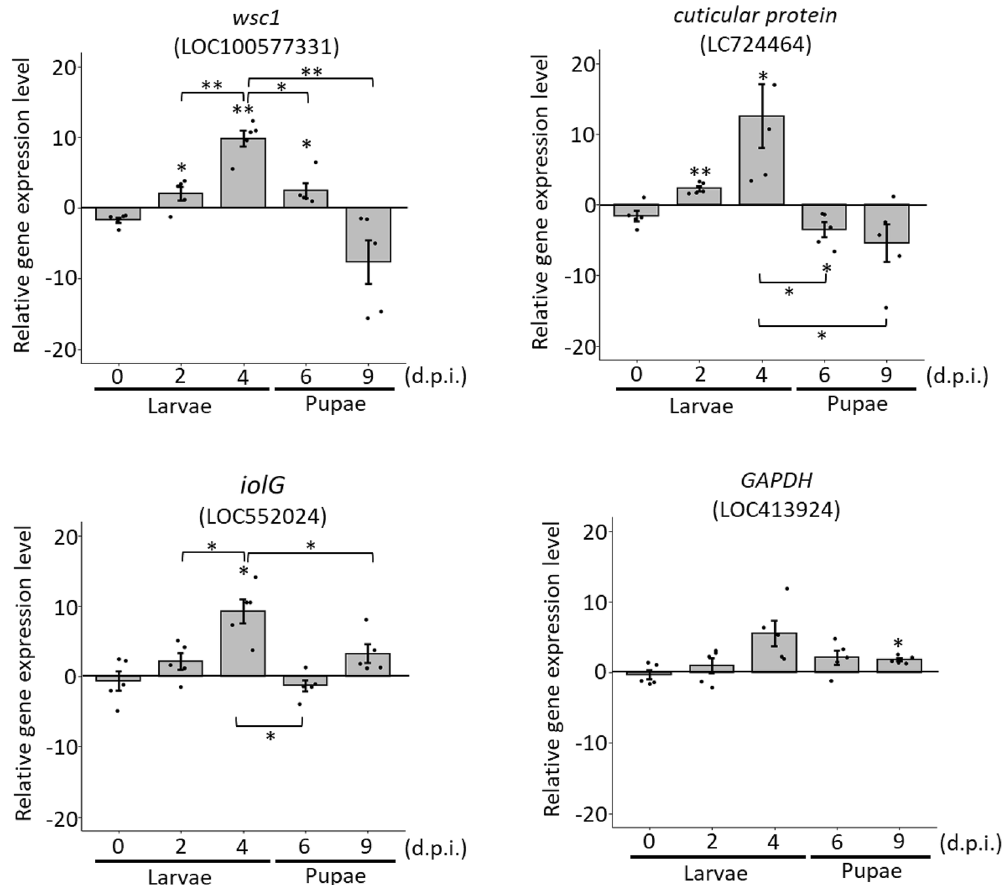
Figure 5. Validation of upregulated genes at 0, 2, 4, 6 and 9 d.p.i. The mean ± SD was calculated for relative gene expression levels using the 2 −ΔΔCt method (Livak &Schmittgen 2001). All experiments were performed in five replicates. * P < 0.05; **P < 0.01.